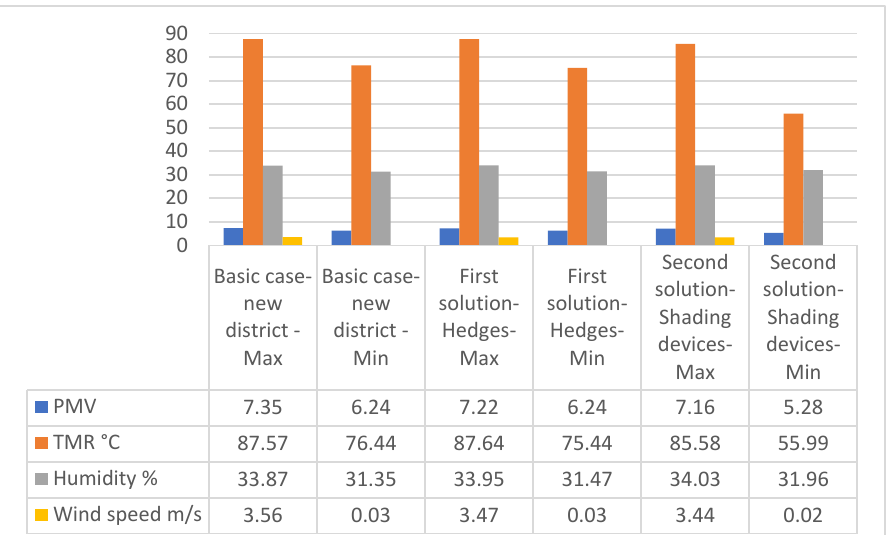
Figure 10. The PMV, MRT, humidity, and wind for the base new case and the solutions at 12:00 pm on 21st of August at height of 1.8 m.